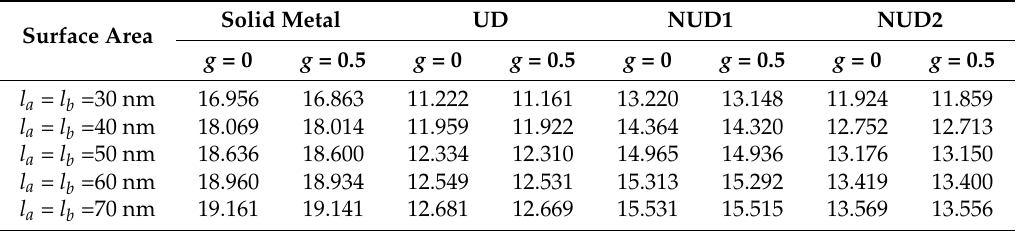
Table 3. The non-dimensional critical buckling loads with different surface areas, small scale parameters and porosity distributions of square nanoplate ( m = n = 1, h = 5 nm, ζ = 1, λ =